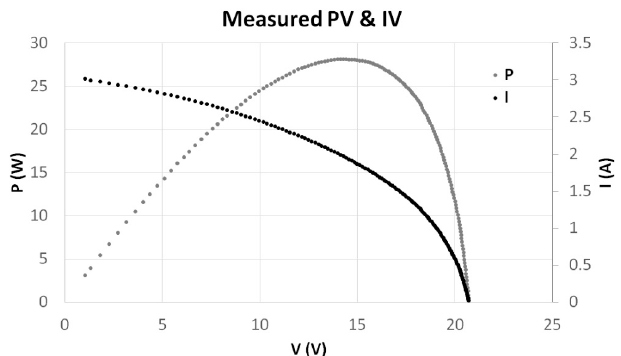
Electron. Mater. 2022 , 3 , FOR PEER REVIEW Figure 7. Measured IV and PV curves of the panel under study. Figure 7. Measured IV and PV curves of the panel under study.